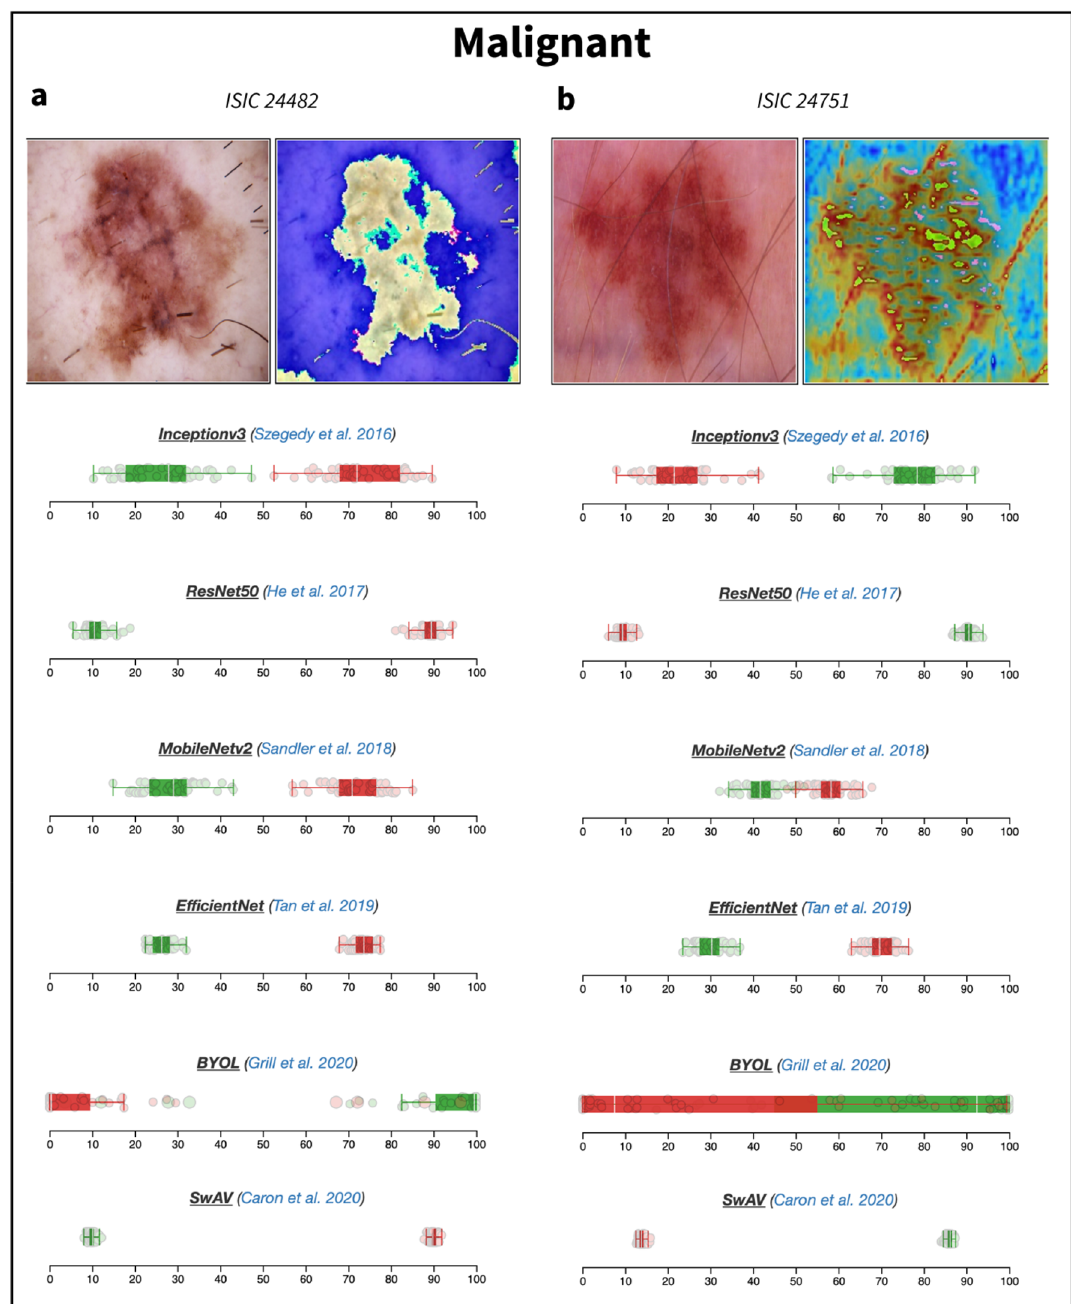
Figure 2. Boxplots representing uncertainty estimates provided by the six CNN models available on DUNEScan for the following skin lesion images: ISIC_0024482 ( a ) and ISIC_0024751 ( b